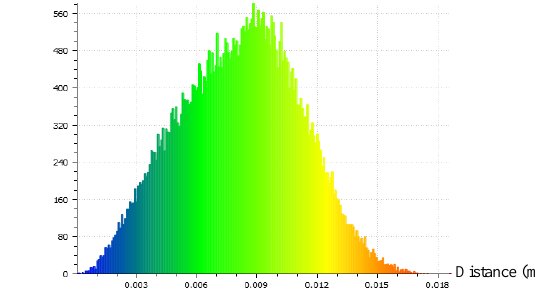
Figure 17. Point-to-point distance histogram after simple registration. Algorithm evaluation using a SLAM and ICP